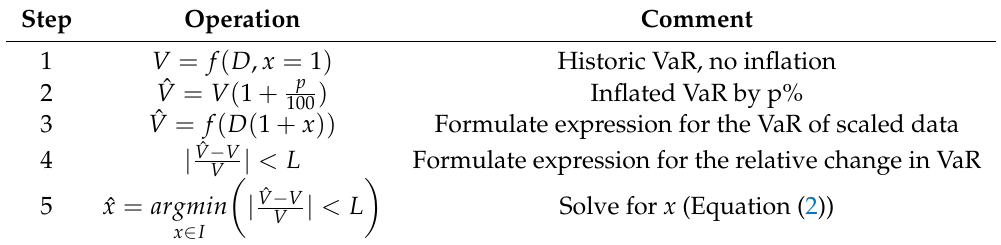
Table 1. Optimization framework: principal